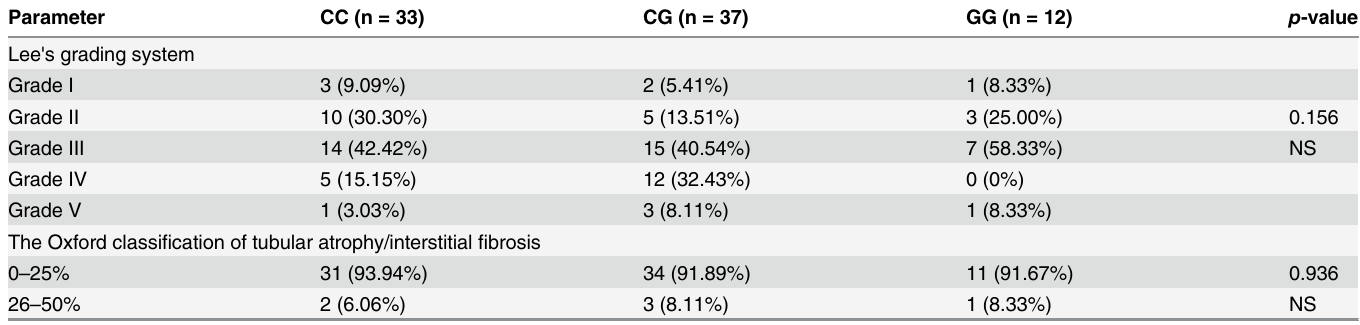
Table 5. Distribution of the genotype frequencies among different grades in subgroup (sick time < 1